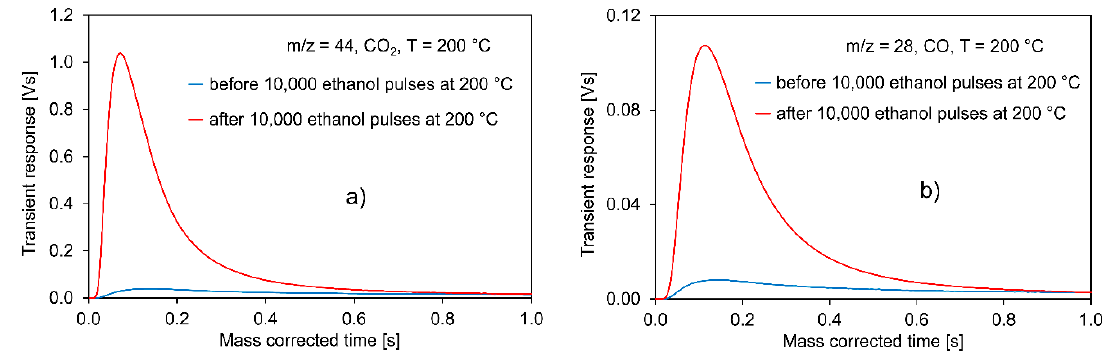
Figure 5. Transient responses of: ( a ) CO 2 and ( b ) CO to pulses of 50% O 2 in Ar at 200 °C before and after 10,000 pulses of ethanol (34.6 vol % in Ar) were pulsed over the H 2 pre-reduced Pt / C catalyst (20 mg) at 200 °C.